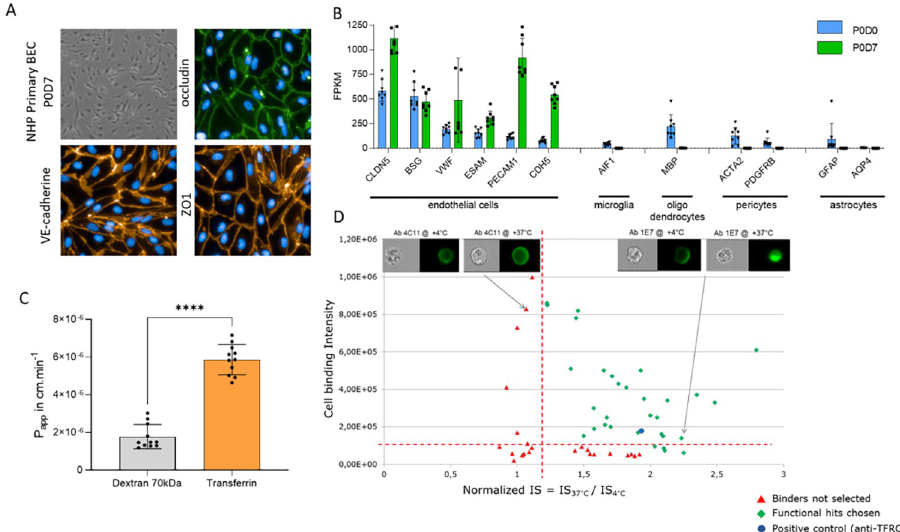
Fig 1. Cell production and antibody screening. (A) NHP primary brain cells isolated at passage 0 after 7 days in culture. Cells were observed 100X magnification with inverted microscope and 200X magnification with fluorescent microscope. Immunofluorescence staining: ZO1 and VE-cadherin labelling in orange, occluding in green and nuclei with Hoechst in blue (B) NHP primary BMECs characterized by RNA Seq. Endothelial, microglial, oligodendrocytes, pericytes and astrocytes markers are represented. Blue bars represent analysis from microvessels P0D0 and green bars represent analysis from P0D7 cultured cells (C) Transferrin and Dextran 70kDa transcytosis in NHP BMECs. Results are given as the P app in cm.min -1 The statistical significance of differences between groups was analyzed using GraphPad Prism v9.0.0 software (GraphPad Software) and Mann–Whitney test p-value < 0.0001. (D) Monoclonal antibody selection into NHP BMECs. The two selection criteria were cell binding and normalized IS. Green diamonds were selected, red triangles were rejected. The blue point was the anti-TFRC antibody added as a control. Pictures show 4C11 as not internalized antibody and 1E7 as internalized